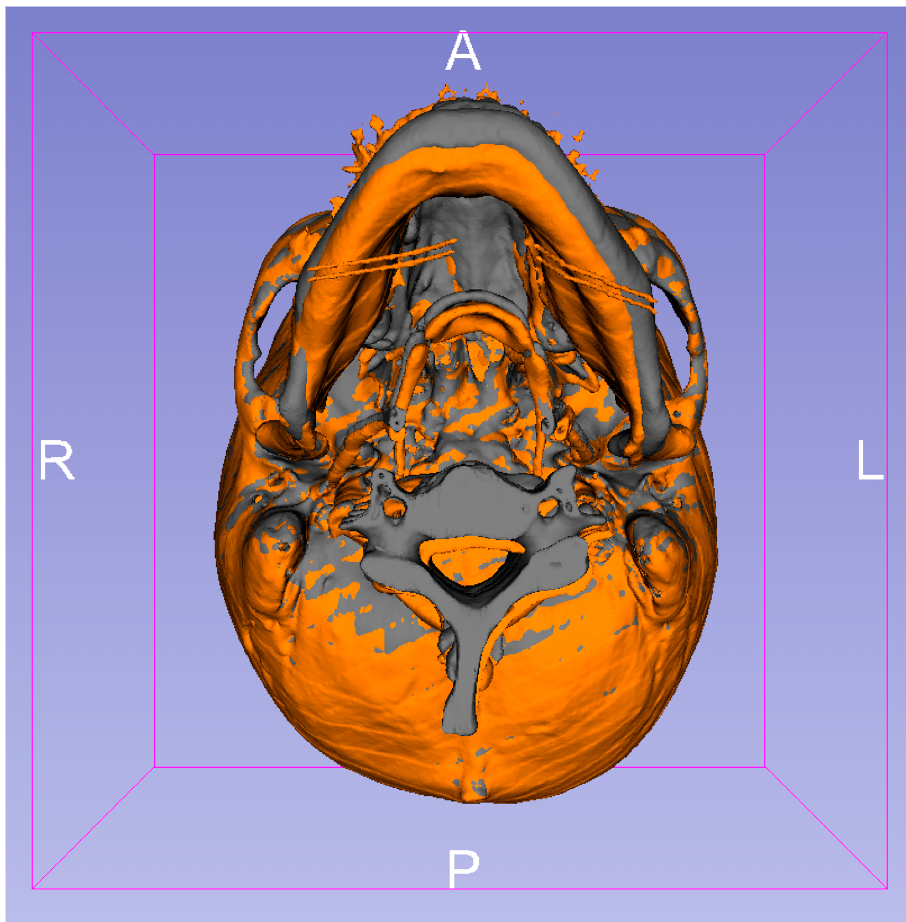
Figure 2. The superimpositions of presurgical (T1, gray color) and post-surgical craniofacial area (T2, orange color) were registered to the cranial base using a voxel-based registration algorithm (inferior view).